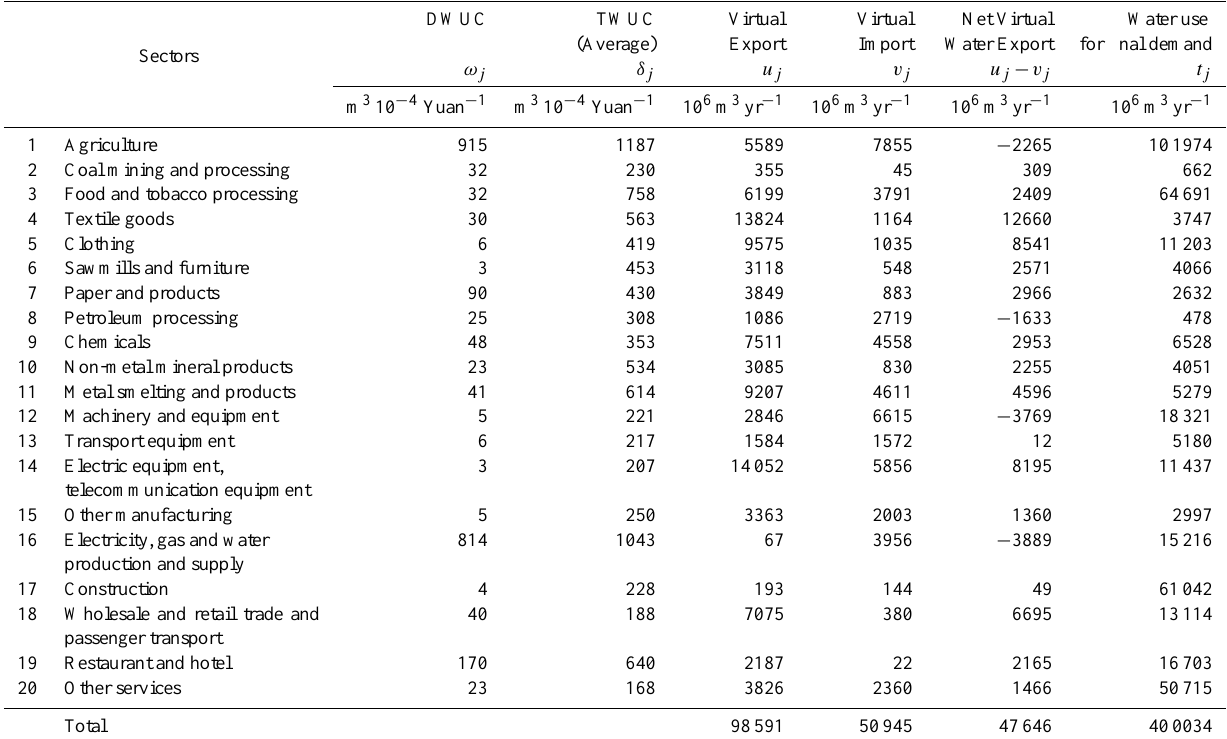
Table 1. Detailed results of sectoral virtual water trade accounting (2002). DWUC TWUC Virtual Virtual Net Virtual Water use (Average) Export Sectors